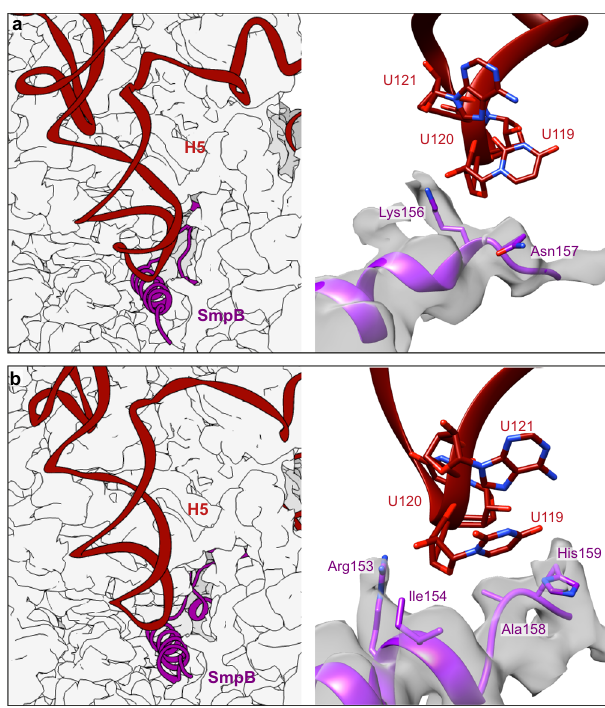
Fig. 5 Detailed view of the interactions between the C-terminal tail of SmpB and the H5 stem-loop of tmRNA. Left: position of the H5 stem-loop at the entrance of the mRNA channel. Right: focus on the residues involved in the interactions between SmpB and H5 during the a pre-accommodation and b accommodation states. SmpB is purple, tmRNA is red and the surface of the ribosomal small subunit is light grey. Residues and nucleotides within 4 Å of each other are indicated, and the cryo-electron density map of SmpB is